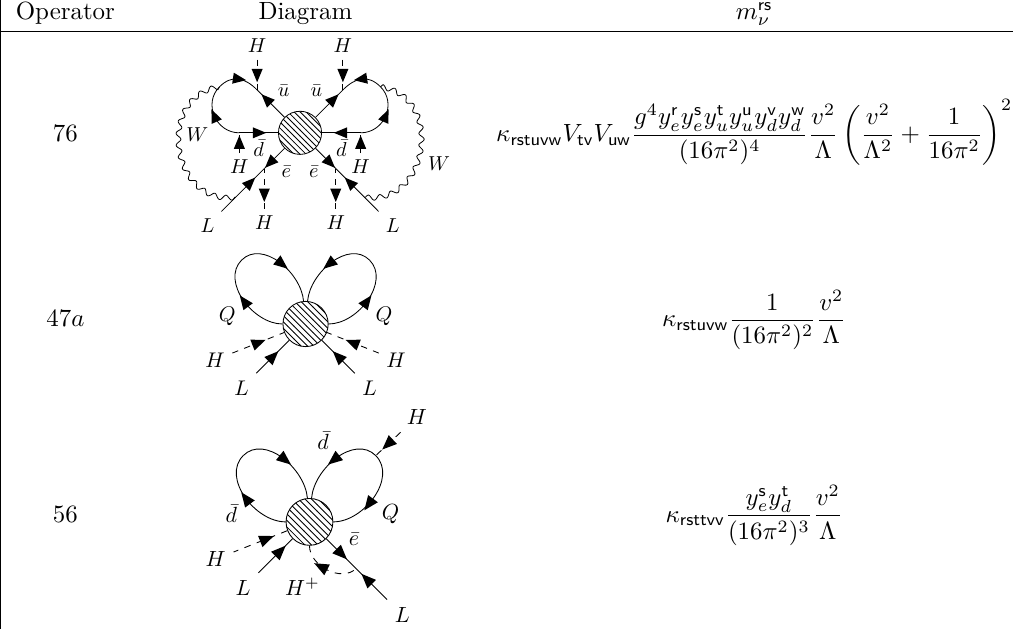
Table 3 : The table shows an assortment of ∆ L = 2 operator closures, displaying a number of paradigmatic motifs. We represent flavour indices in a sans-serif typeface here to avoid confusion with subscripts labelling the Yukawa couplings. The expressions given for m rs needs to be sym- ν metrised in rs , something we do not explicitly indicate in the table. These expressions carry flavour indices in alphabetical order on the fields as they appear in table 8. Here κ represents the opera- tor coefficient, V is the CKM matrix and y r are the diagonal electron, up-type and down-type e,u,d Yukawa couplings in the SM. A number of operators require an external electron to be converted into a neutrino. This often necessitates the introduction of a W boson or an unphysical charged Higgs H + . Operator O 8 generates the dimension-seven analogue of the Weinberg operator with the two-loop diagram shown. (There is a lower order diagram with an H + in place of the W that happens to vanish [85].) A three-loop diagram in which two of the external Higgs lines are looped off leads to mixing with the Weinberg operator. Operator O 76 generates the dimension-nine operator LLHH ( H † H ) 2 , and hence five- and six-loop diagrams are also implied. There is usually more than one choice about where to attach the W boson if one is present in a diagram, and the additional diagrams with the W connecting in other possible ways are left